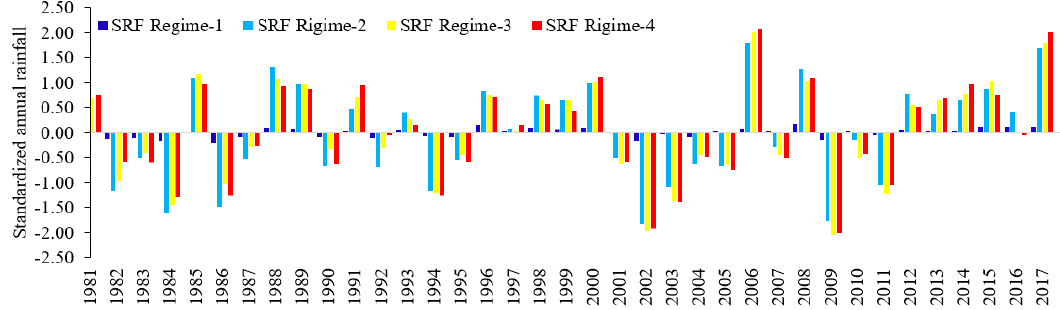
Figure 8. Standardized annual rainfall for each rainfall regime zone (Figure 7) in each year.